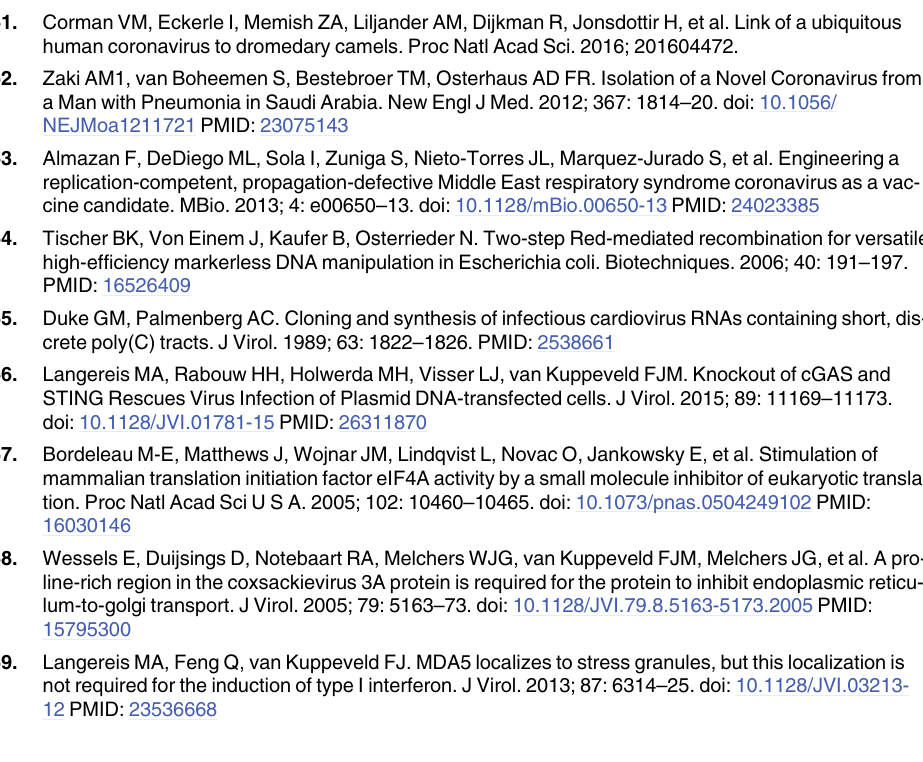
PLOS Pathogens | DOI:10.1371/journal.ppat.1005982 October 26,